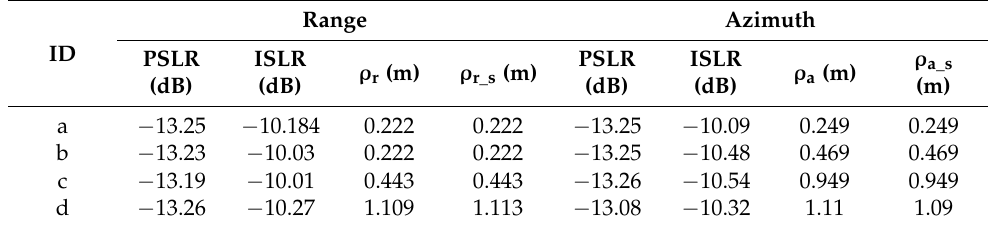
Figure 12. Imaging focusing results of HEO SAR at different orbital moments. ( a ) At perigee. ( b ) In the squint subduction section in the first half of orbit period. ( c ) In the squint subduction section in the latter half of orbit period. ( d ) At apogee. Table 3. Parameters of the focused